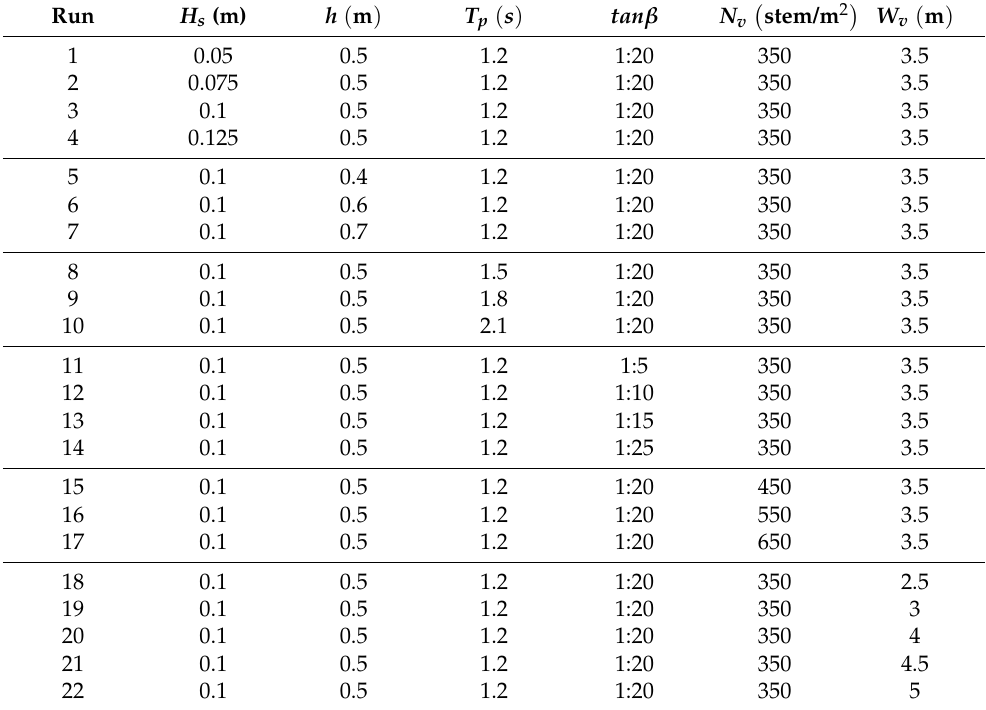
Table 2. Parameter setups for different simulation